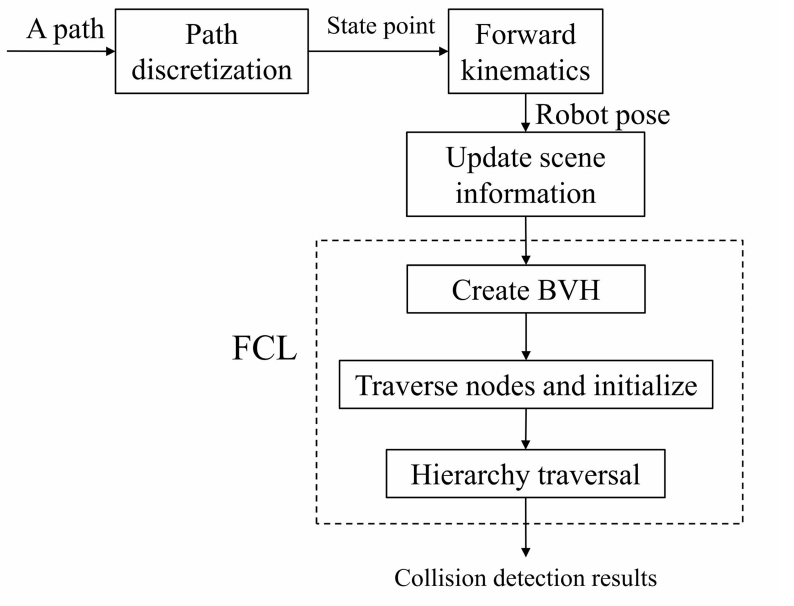
Figure 5. Collision detection process based on